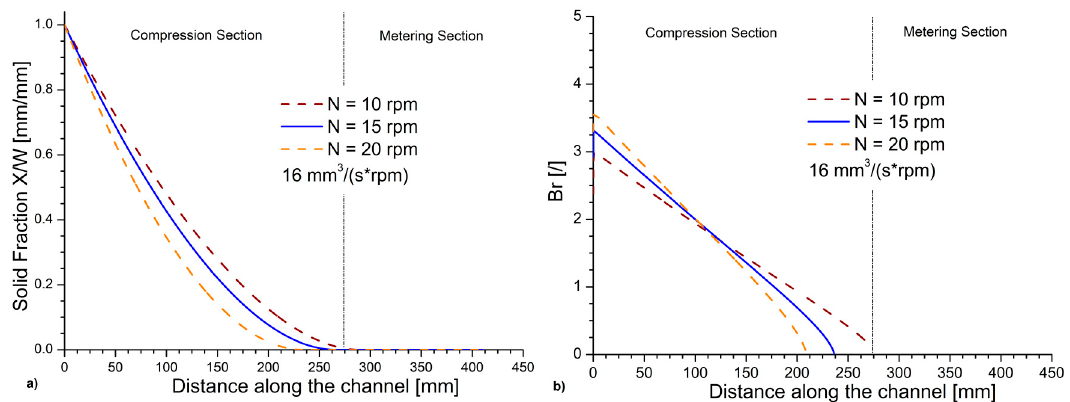
Figure 8. ( a ) Melting profile; and ( b ) Brinkman number for different screw frequencies under flood feeding considering otherwise the micro-extrusion settings and material parameters of Table 1 (Column 2). Blue (reference) lines as in Figure 4.